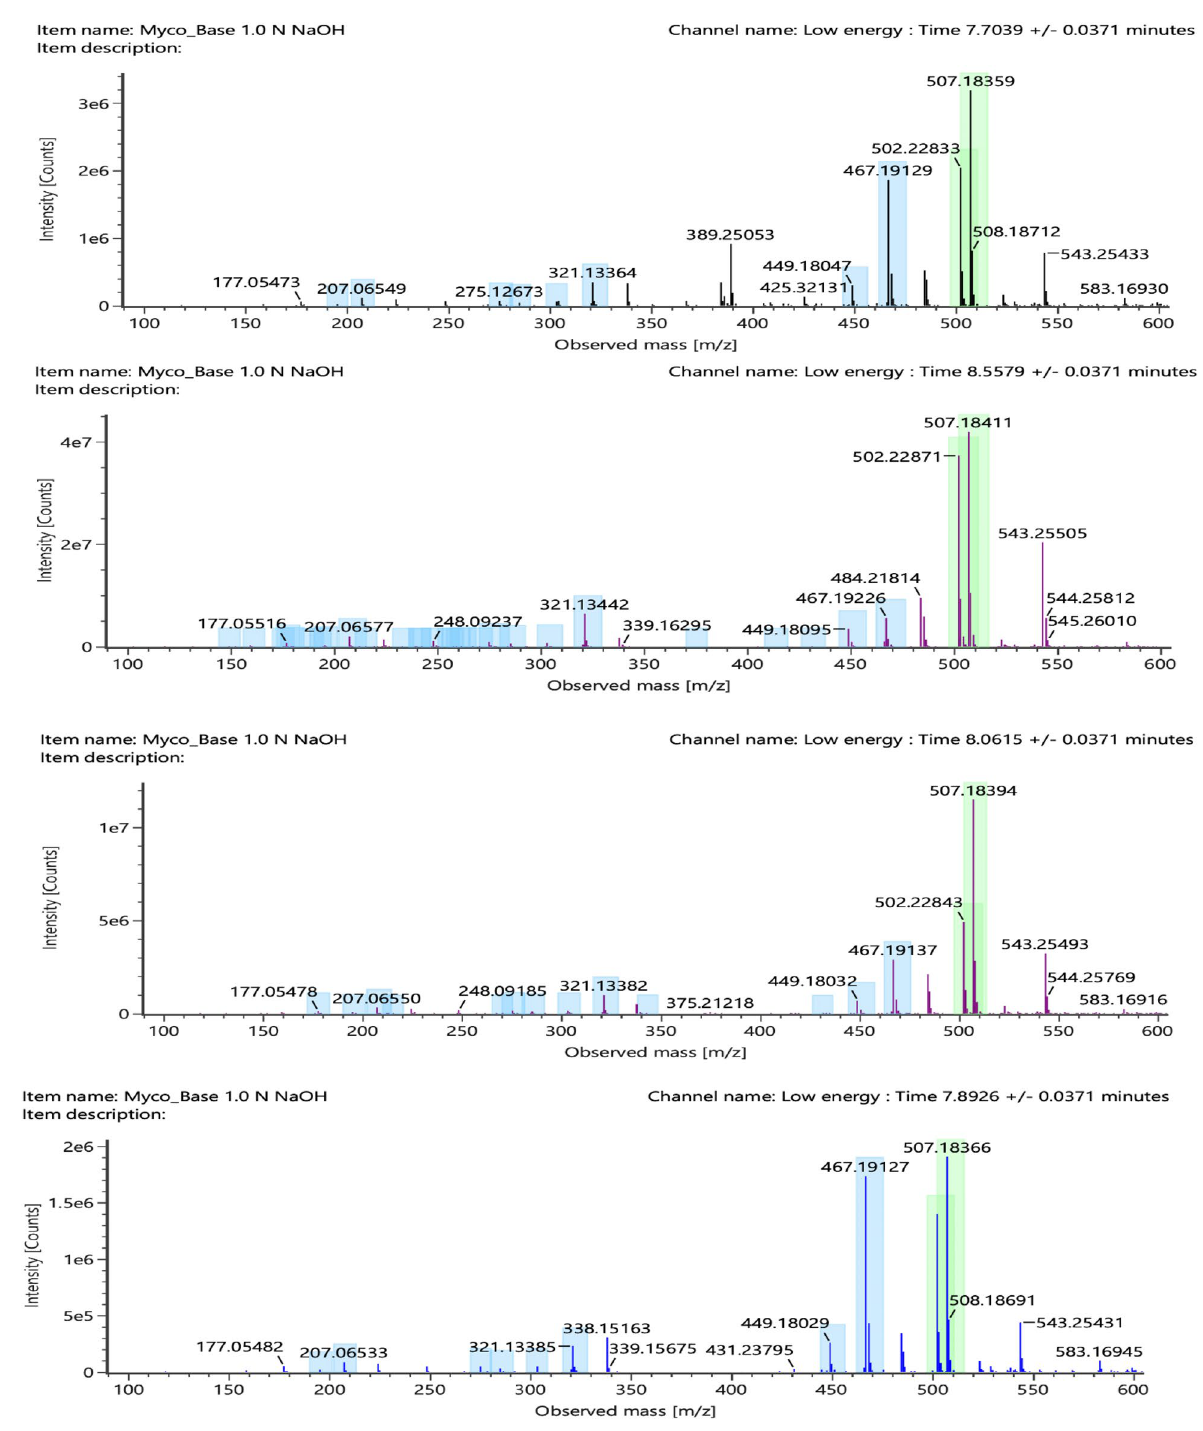
Figure 6. Positive mode low energy mass spectrums ( a ) Unknown at RRT 0.84; ( b ) Unknown at RRT 0.85; ( c ) Unknown at RRT 0.87; ( d ) Mycophenolic acid sorbitol